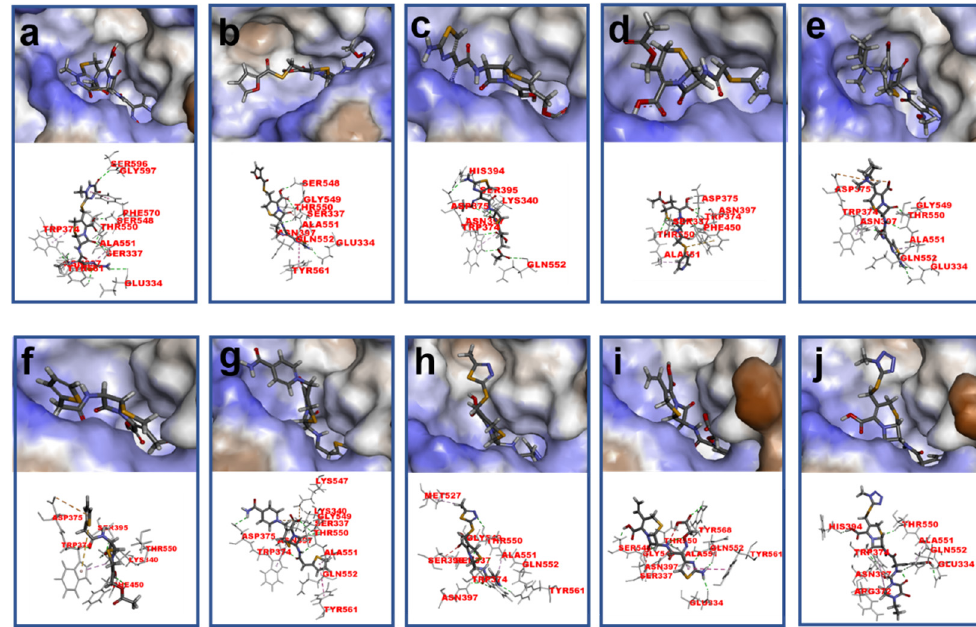
Figure 5. Schematic representation of the interactions between PBP2x* (PDB code: 2z2m) and ( a ) CTRX; ( b ) CFT; ( c ) CTX; ( d ) CFAP; ( e ) CFP; ( f ) KF; ( g ) CFN; ( h ) CFZ; ( i ) CFM; and ( j ) CPZ. Hydrogen bonds are shown as green dashed lines, and hydrophobic interactions are displayed as purple dashes.